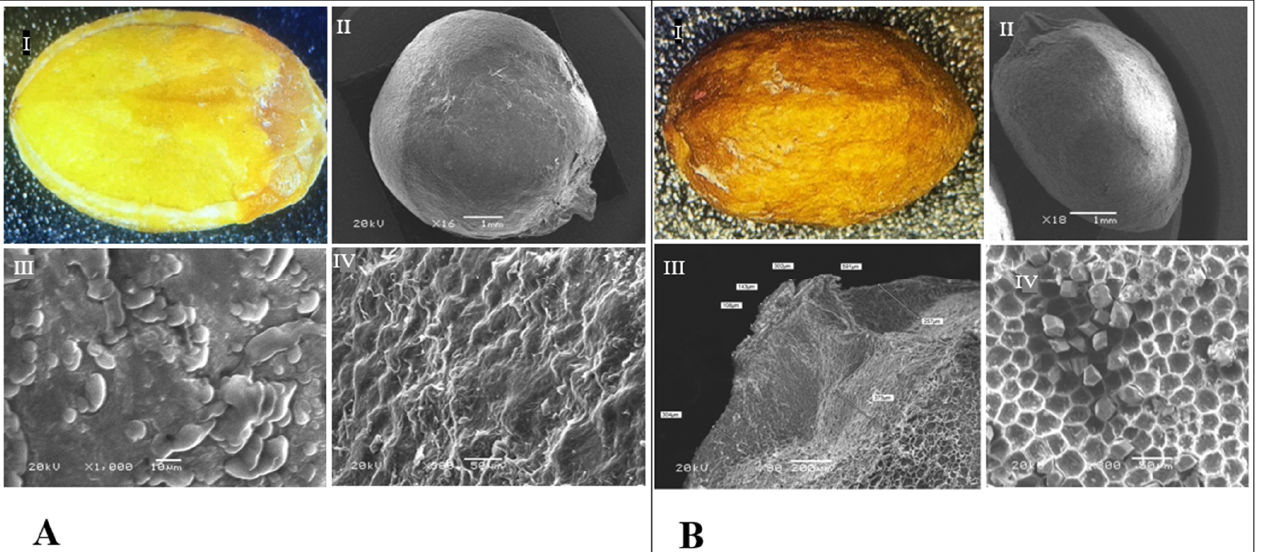
Table 6. Seed macro-morphological variations of Commiphora species using L.M.